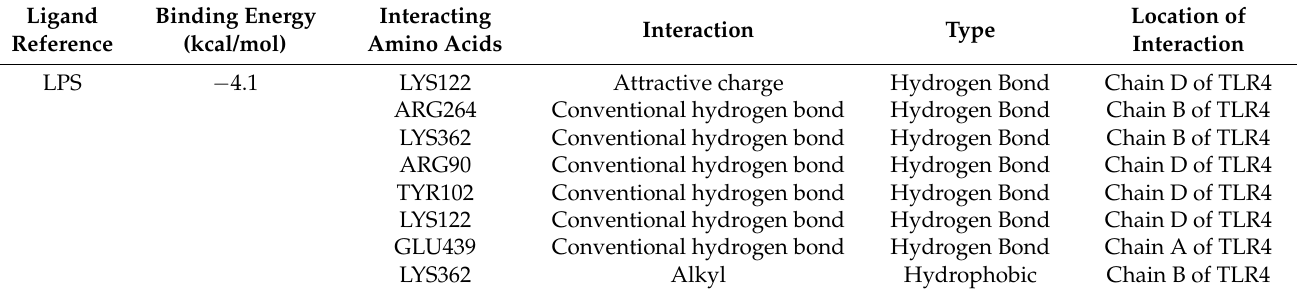
Table 1. Binding energy of reference compound lipopolysaccharide with the human Toll-like receptor